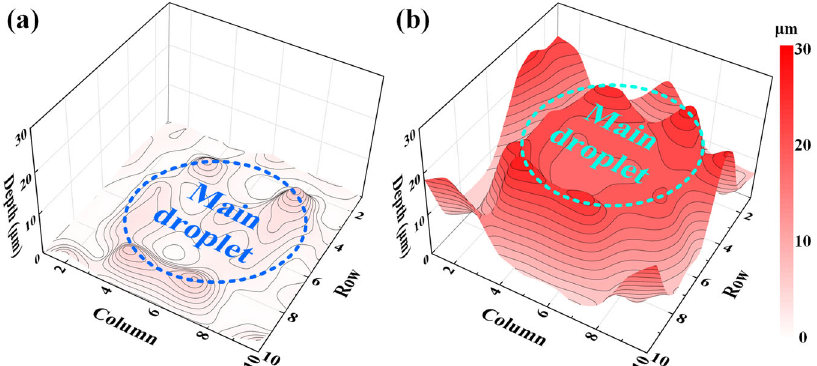
Fig. 7 The calculated corrosion depth. The map of the corrosion depth calculated from a macro-cell current and b local 3D pro fi les.